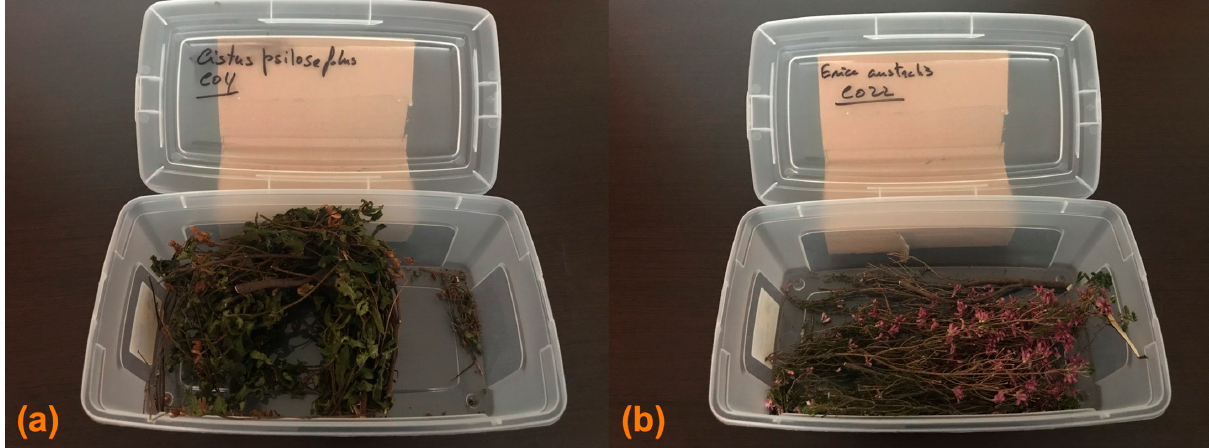
Figure 2. Examples of the samples collected. ( a ) Sample of Cistus psilosepalus and ( b ) sample of Erica australis .